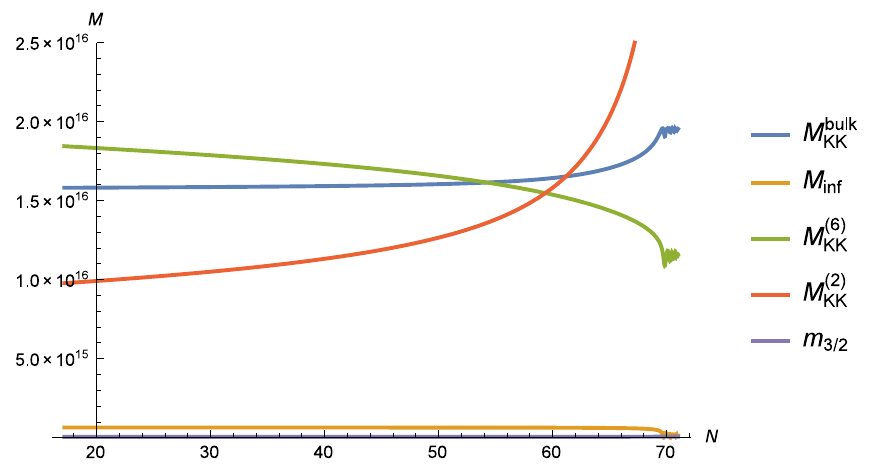
= M (2) ), the inflationary scale M inf = V 1 / 4 KK KK